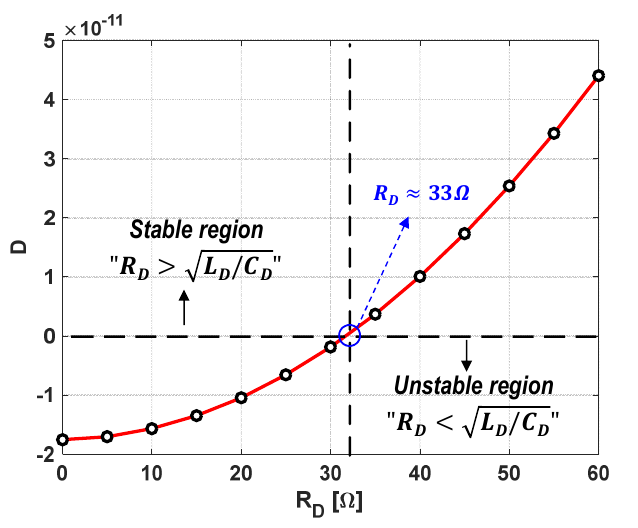
Figure 4. The condition of R D for LNA input matching and